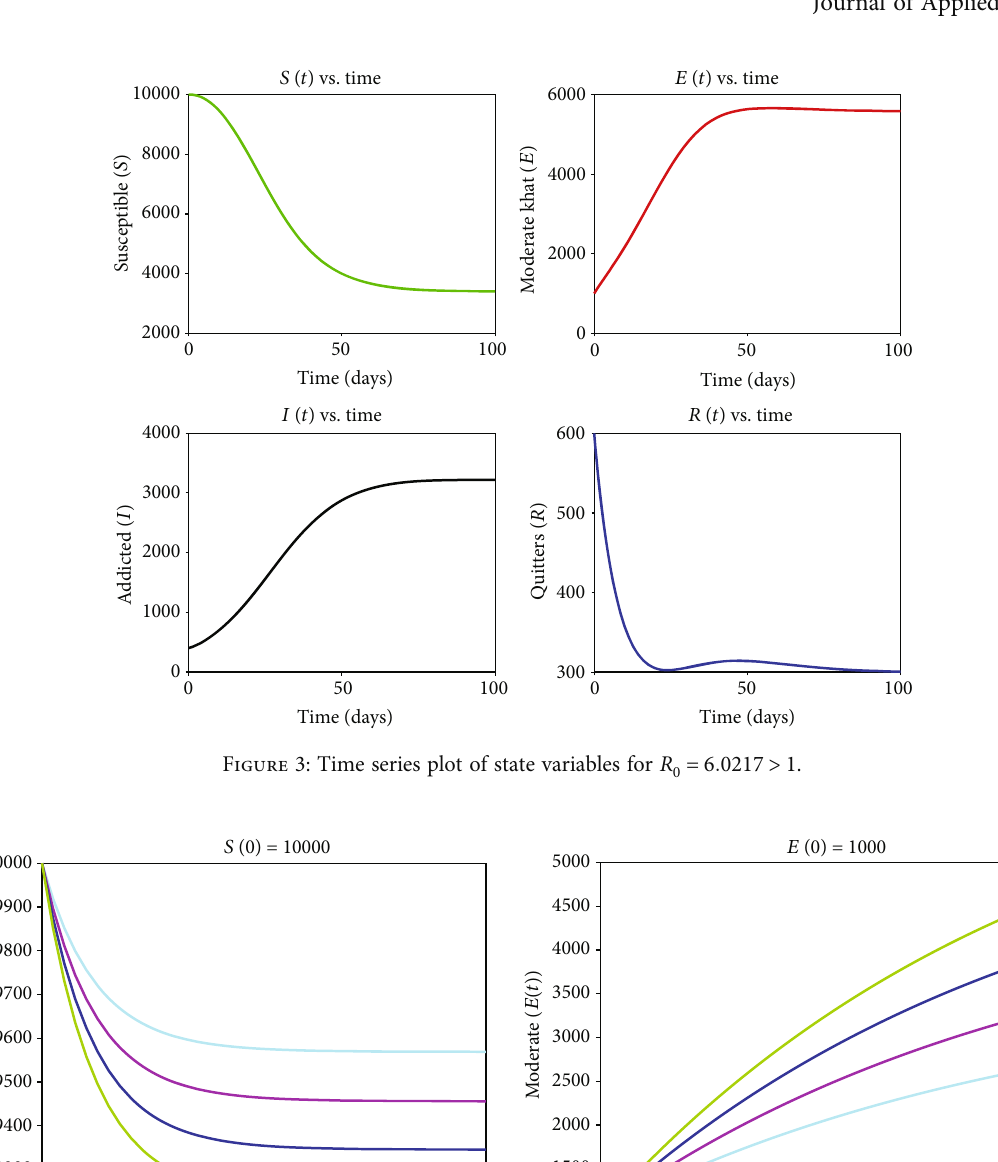
Figure 4: Susceptible and moderate khat chewer population with varying e ff ective contact rate ( α ).